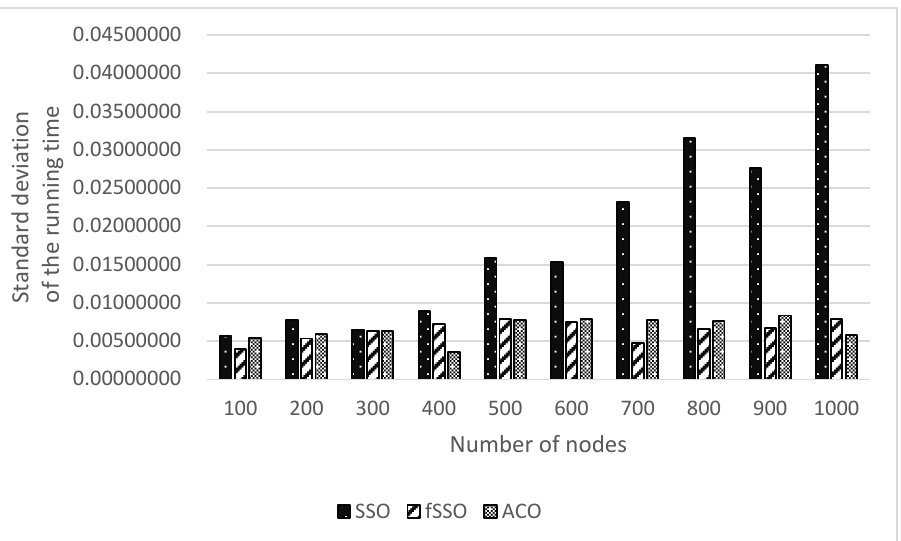
Figure 13. Average of the running time for ten benchmarks.